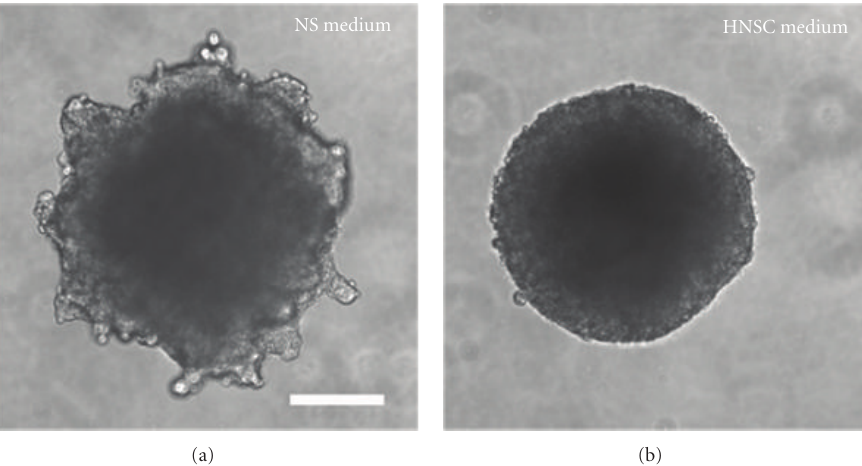
Figure 2: Long-term propagated porcine ventral mesencephalic (VM) neural tissue spheres (NTS). The NTS were propagated in either (a) neurosphere- (NS-) proliferation medium or (b) human neural stem cell- (HNSC-) proliferation medium. Scale bar: 200 μ